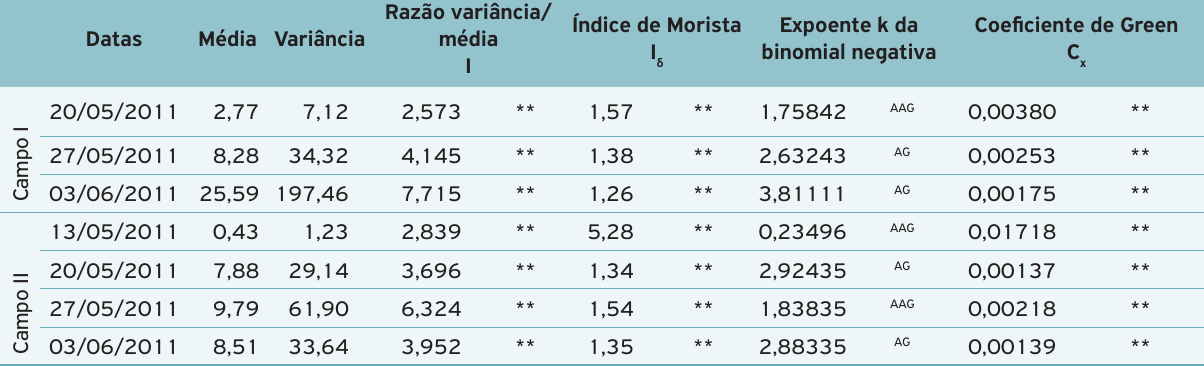
Tabela 1. Média, variância, razão variância/média, índice de Morisita, expoente k da binomial negativa e coeficiente de Green para